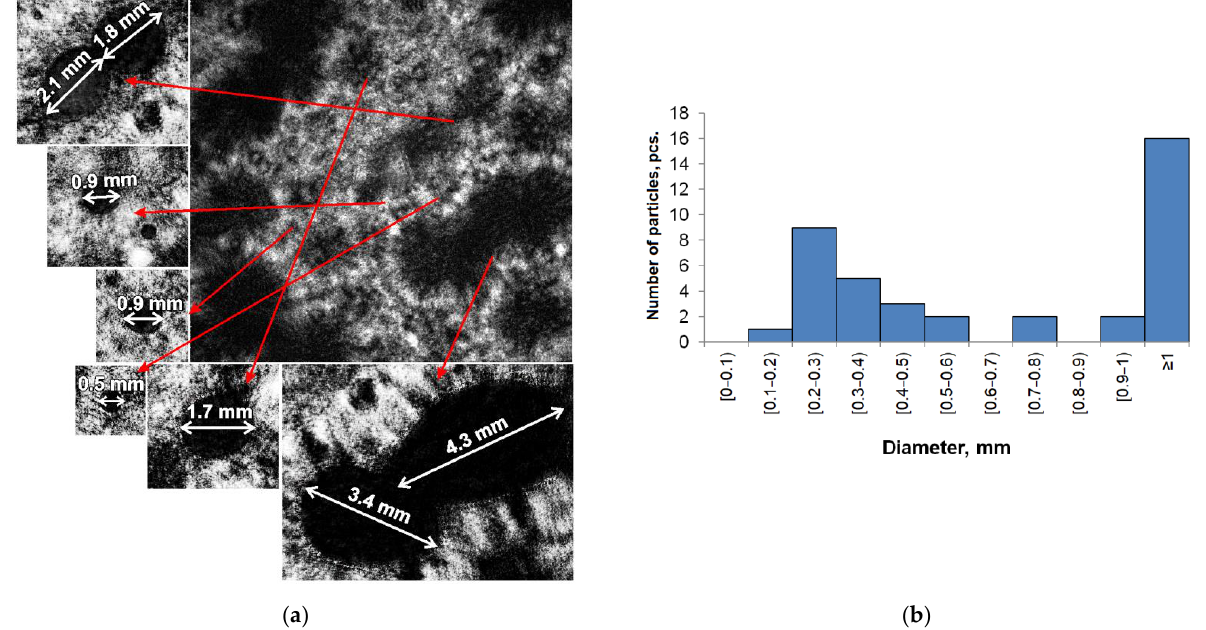
Figure 14. DHC hologram and some reconstructed images of bubbles in the 1 m surface layer at station No. 6975 in close proximity to the gas flame ( a ); histogram of distribution by bubble diameters according to the processing of five holograms ( b ).